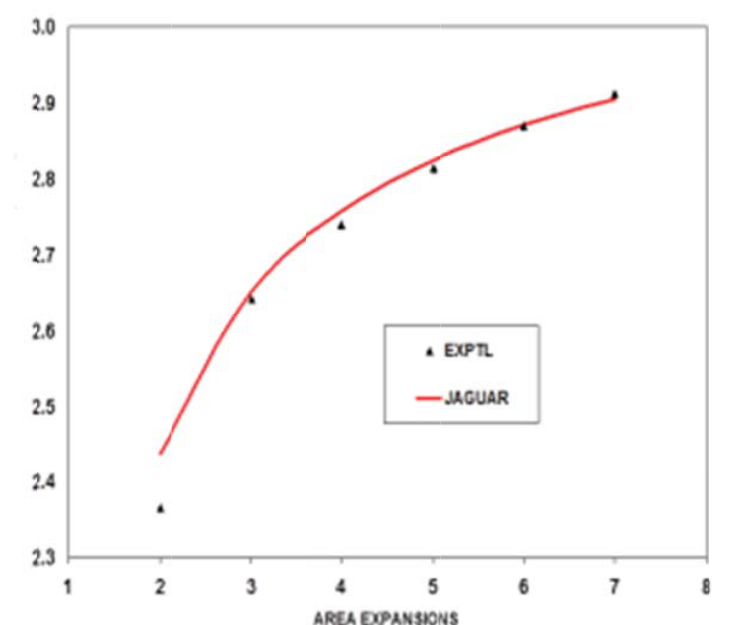
Figu 5.2. Predict Predicting th materials. Th velocities of crystal